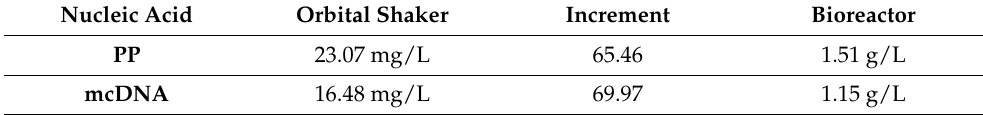
Table 6. Comparison of PP and mcDNA concentration in orbital shaker and